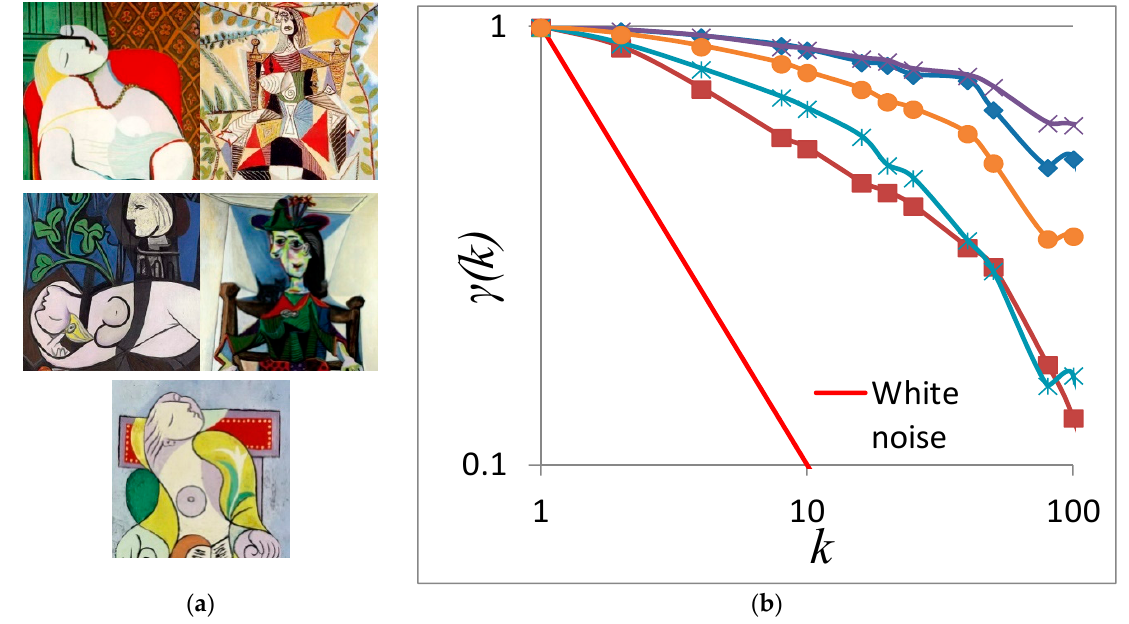
Figure 4. ( a ) Paintings of Pablo Picasso (1881–1973); ( b ) Standardized climacograms of the art paintings of Picasso.